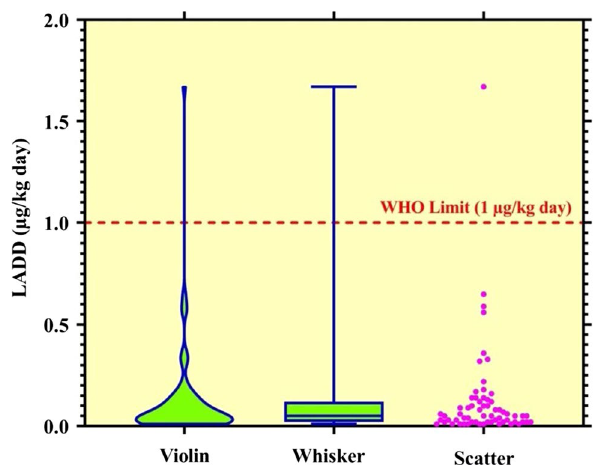
Fig. 14 Frequency distribution of LADD in adult